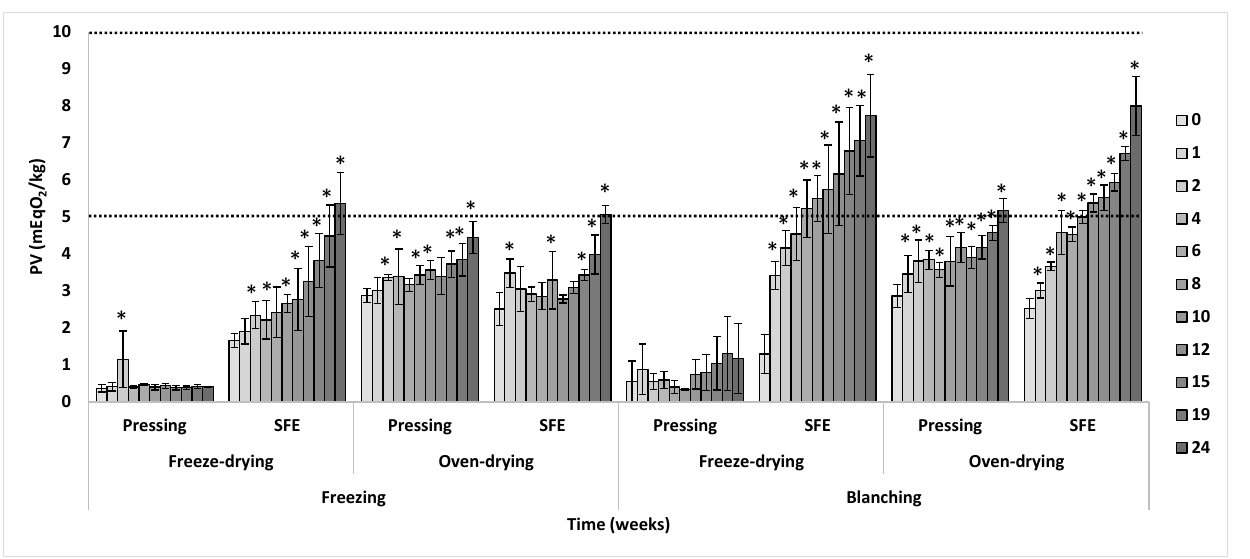
Figure 4. Oxidative stability (PV) during storage of the fat from BSFL processed by different methods of slaughtering, drying, and defatting. Samples with an asterisk within each treatment mean significant difference with respect to its respective initial value at week 0. Each data point corresponds to mean values ± SD, n = 4.